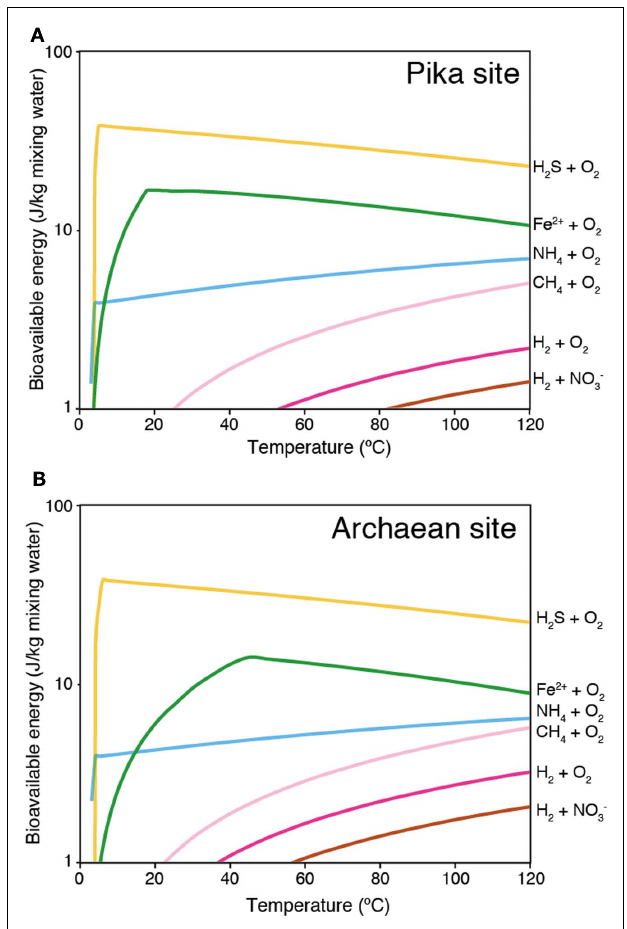
FIGUREA2 |Thermodynamic model calculation of bioavailable energy. Simple mixing between hydrothermal fluid and seawater without any redox and mineral precipitation reactions are assumed in the calculation.The results of (A) Pika and (B) Archaean sites are shown.